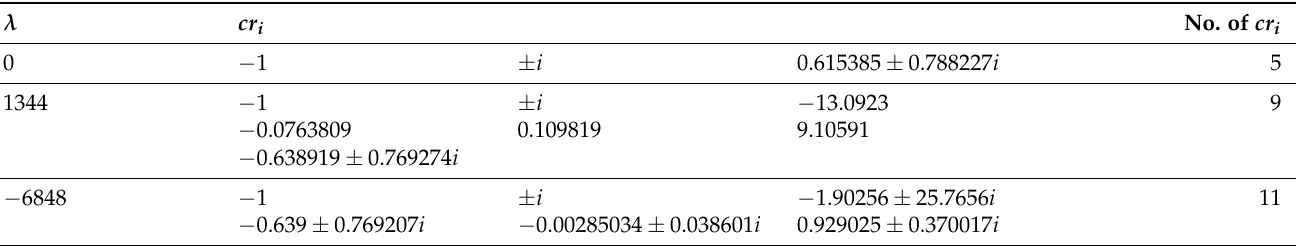
( cr ) for special λ -values. i λ